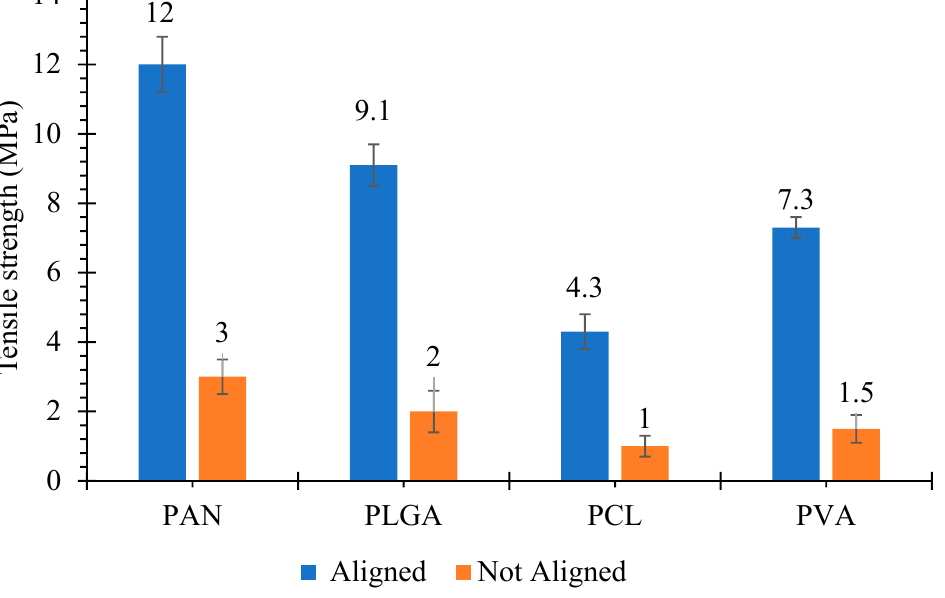
Figure 3. Tensile strength of cylindrical nanofibrous structures, with ‘aligned’ and ‘not aligned’ fibers. It was revealed that tensile strength values were varied for both aligned and not-aligned grafts. In the cases of aligned scaffolds, the PAN scaffolds had the highest mechanical strength of 12 ± 0.8 MPa, while the PCL scaffold had the lowest mechanical strength of 4.3 ± 0.5 MPa. Tensile strength values of PLGA and PVA were 9.1 ± 0.6 and 7.3 ± 0.3 MPa, respectively. Tensile strength values for not-aligned scaffolds were 3 ± 0.21, 2 ± 0.15, 1 ± 0.16 and 1.5 ± 0.14 MPa for PAN, PLGA, PCL and PVA, respectively. It was observed that tensile strength values for aligned scaffolds were greater than that of not-aligned scaffolds. The increase in tensile strength of aligned scaffolds is due to the dense structure of aligned scaffolds. Moreover during tensile loading, fibers that are aligned in the direction of loading experience the stretching force hence show resistance against force [45]. Similar observation of aligned scaffolds with enhanced mechanical properties than not-aligned scaffolds was already reported by Neethu Mohan et al. [46]. A comparison of stress strain behavior for aligned scaffolds and not-aligned scaffolds is displayed in Figure